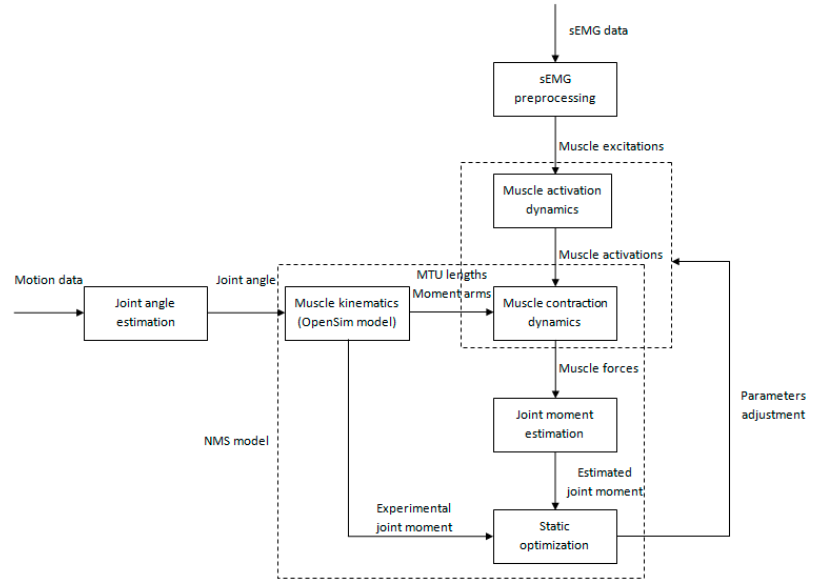
Figure 4. The flowchart of calibration process. Static optimization is used to adjust system parameters in muscle activation dynamics and muscle contraction dynamics.